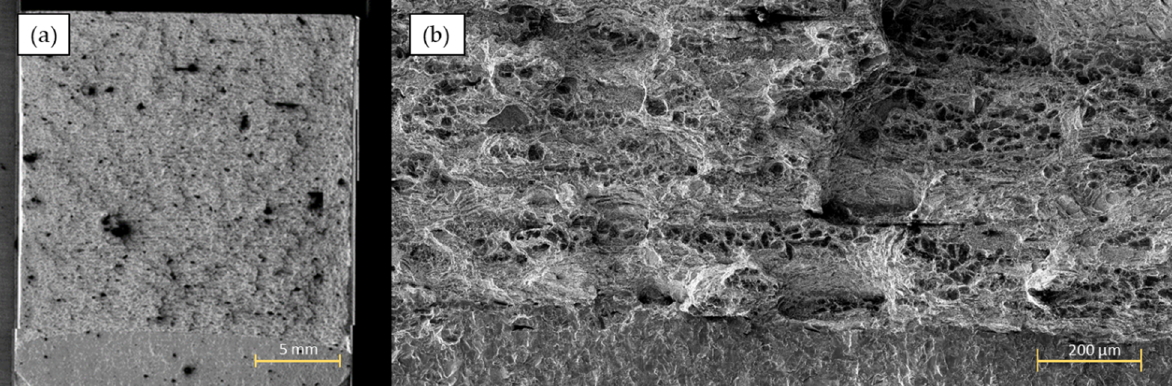
Figure 9. Fractography of a CT specimen for fracture toughness testing of Material B: ( a ) overview of complete fracture sample; ( b ) detailed view showing the orientation of niobium carbides on the fracture surface in the transition area of the pre-crack to the overload fracture surface.